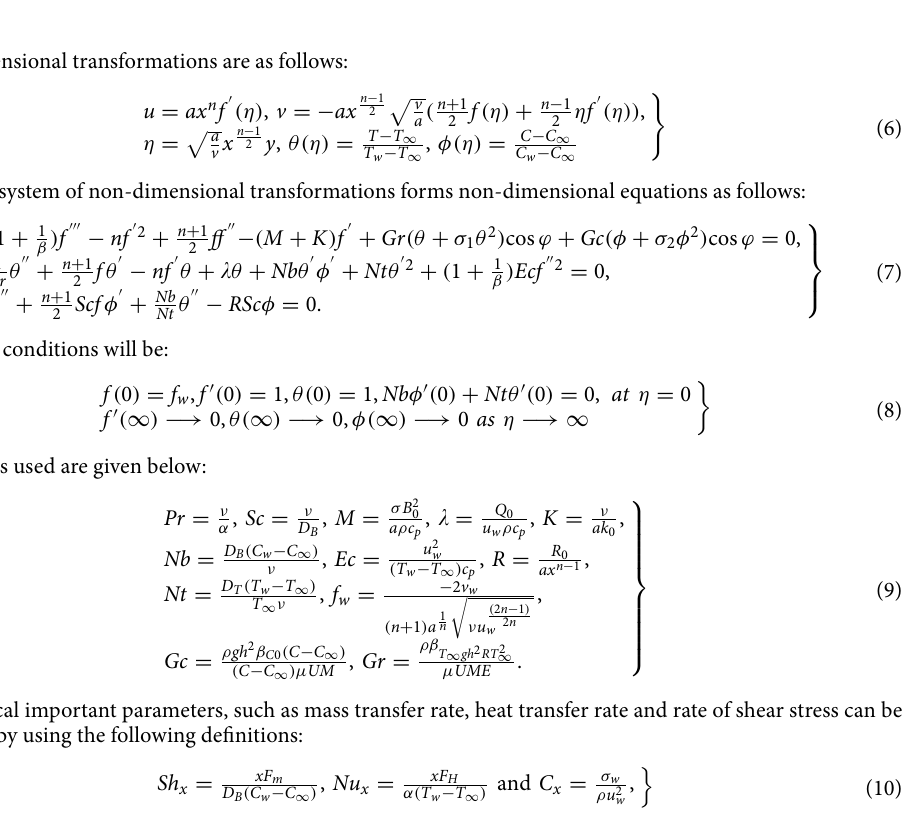
Figure 1. Geometry of the